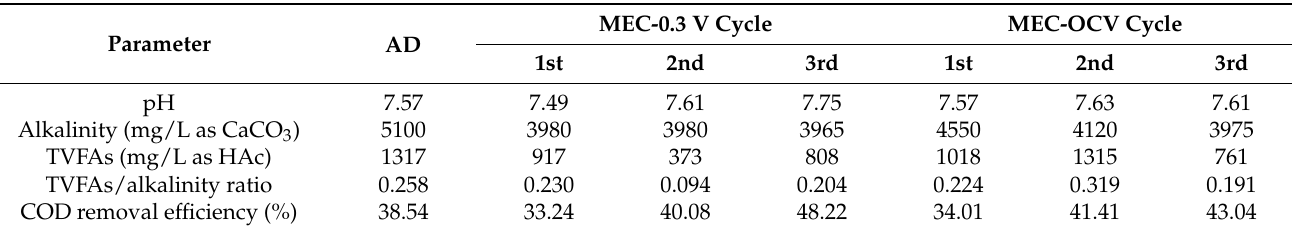
Table 4. Properties of AD, MEC-0.3, and